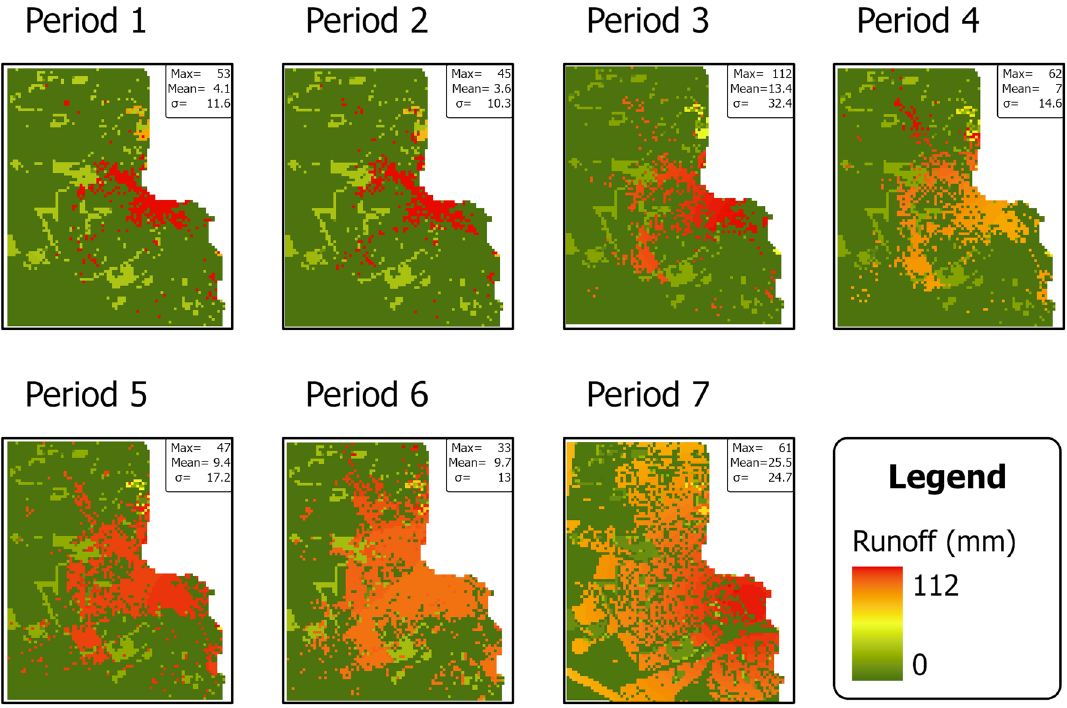
Figure 6. The spatial patterns of average annual surface runoff for the seven studied periods. Boxes in the right top corners show maximum (max), mean (Mean), and standard deviation (σ) values. Maps were created with ArcGIS Pro version 2.9 (https:// www. arcgis. com/).